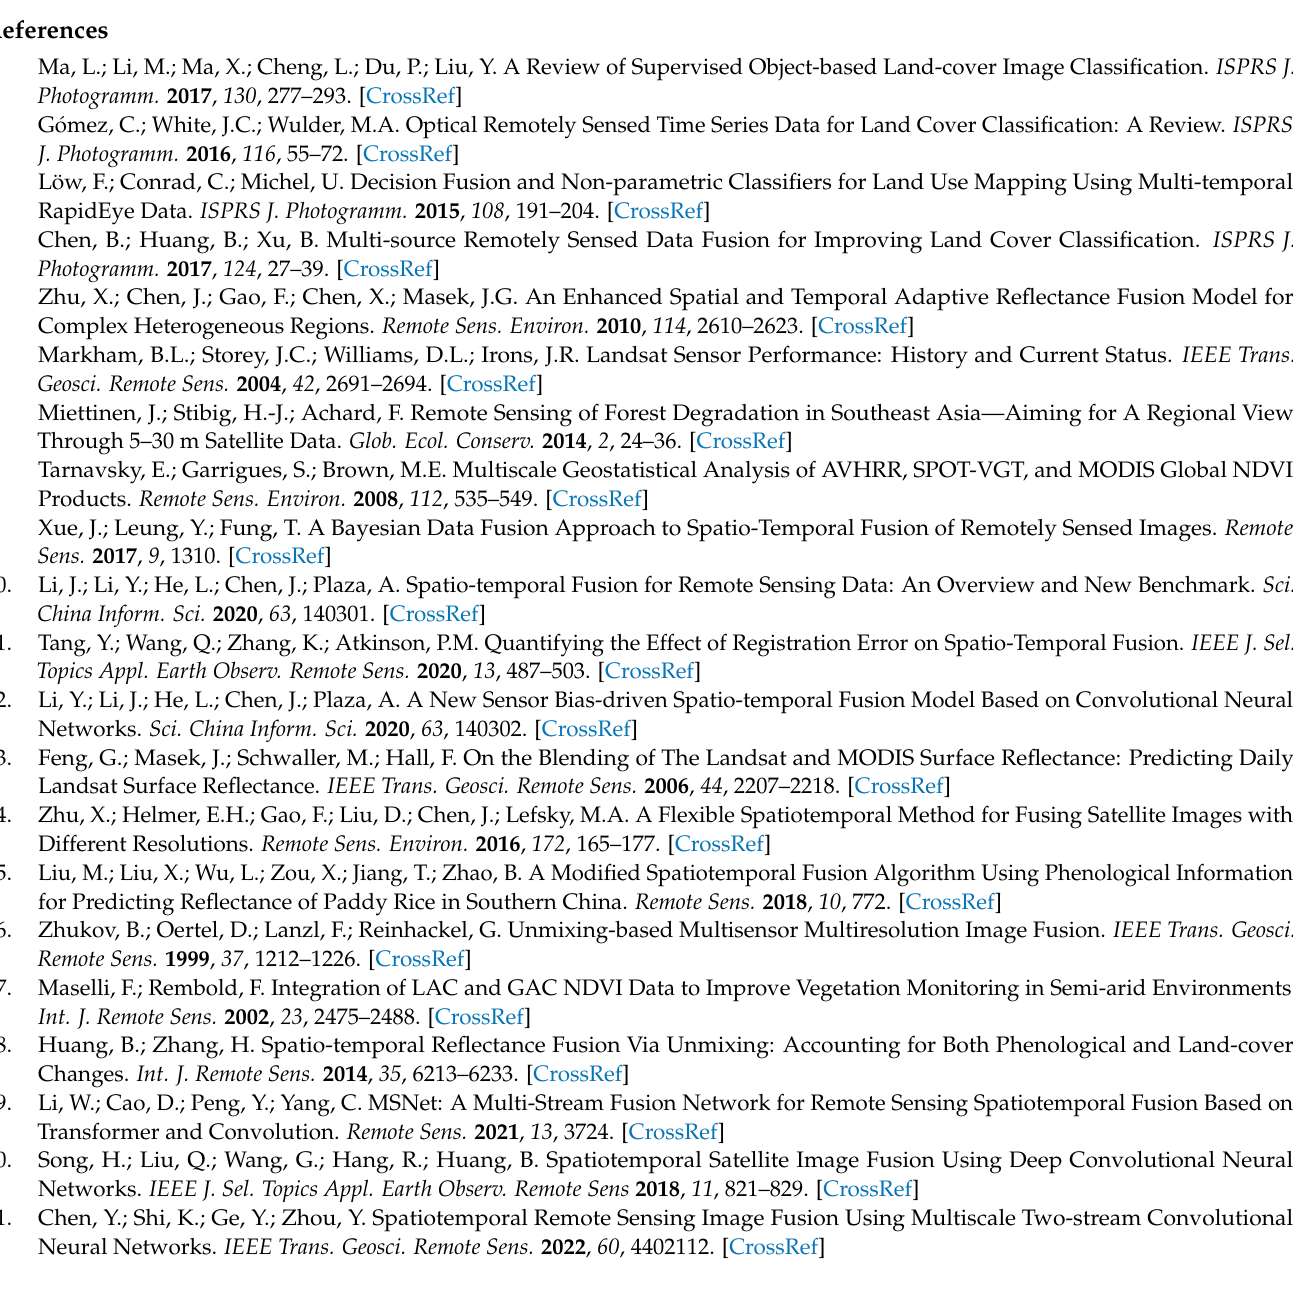
Figure A3. The weight of class membership for ( a ) MODIS and ( b ) Landsat